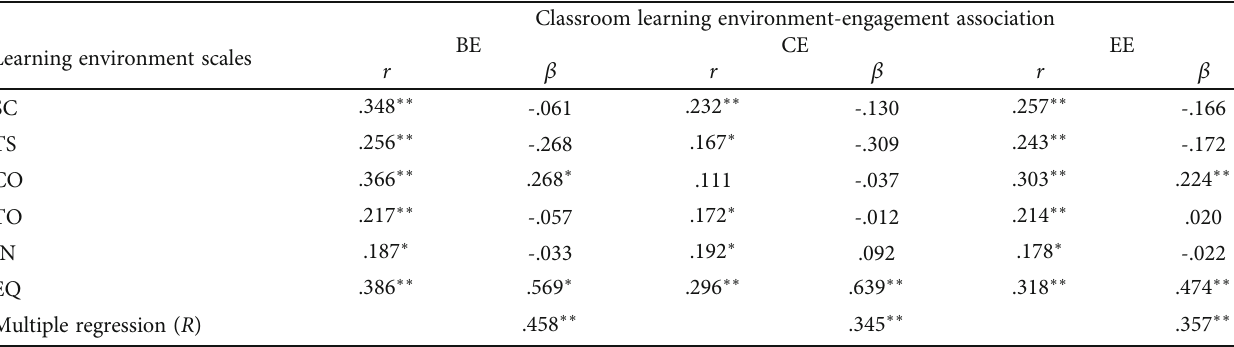
Table 6: Correlation and multiple regression analysis for associations between student engagement and classroom learning environment